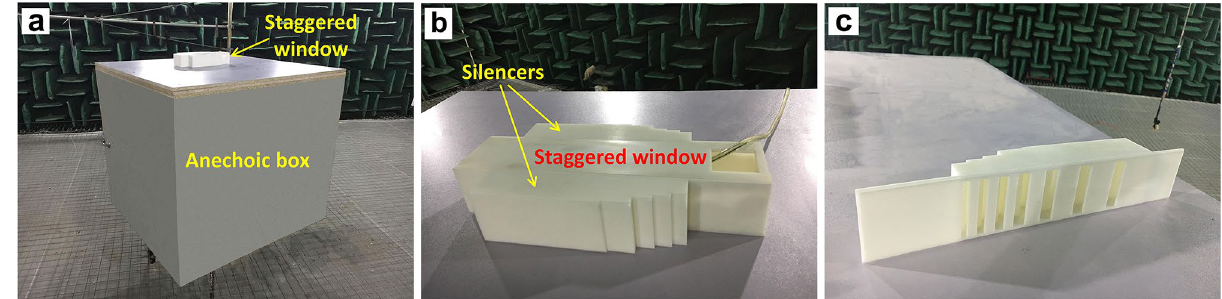
Figure 5. Photos of the experimental setup. ( a ) A panoramic view; ( b ) a detailed view of the staggered window model with silencers installed on the two side walls; and ( c ) the 3D printed silencer.